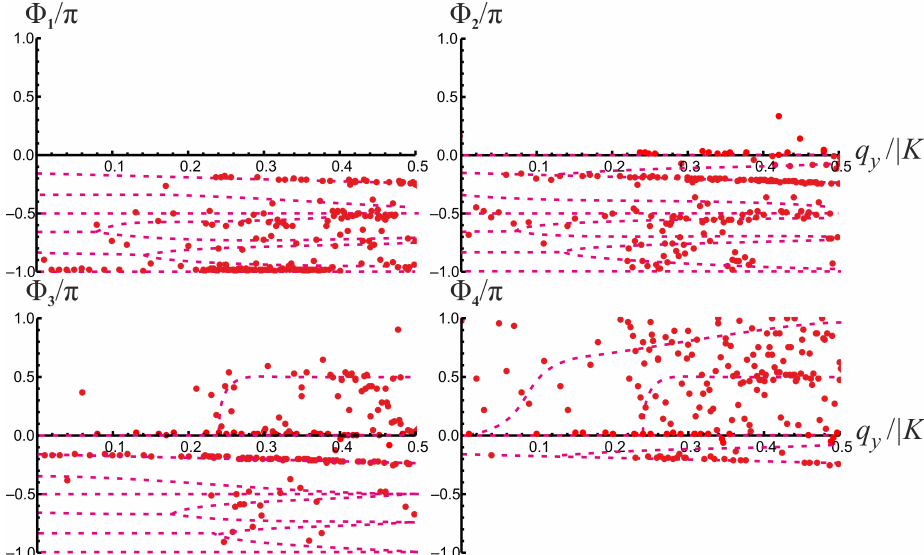
Figure 3. Non-Abelian phases Φ 1 , . . . , Φ 4 of the Wilson-loop eigenvalues in the units of π at non-zero gauge